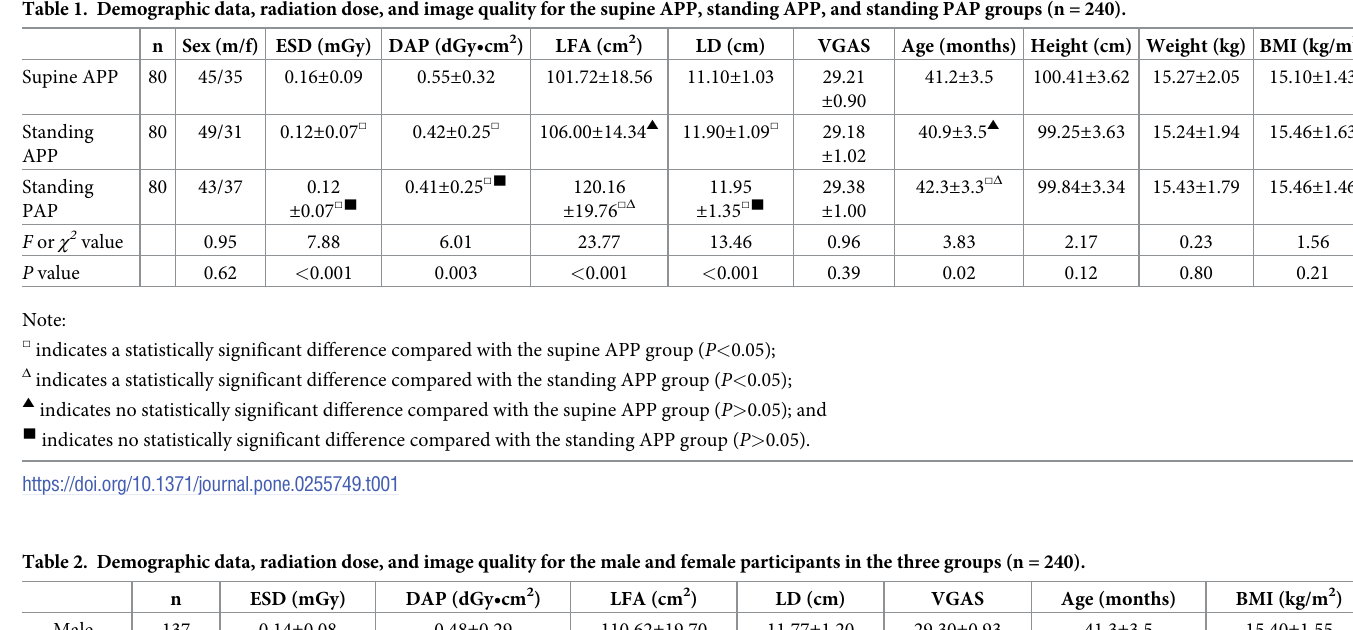
Table 2. Demographic data, radiation dose, and image quality for the male and female participants in the three groups (n = 240).